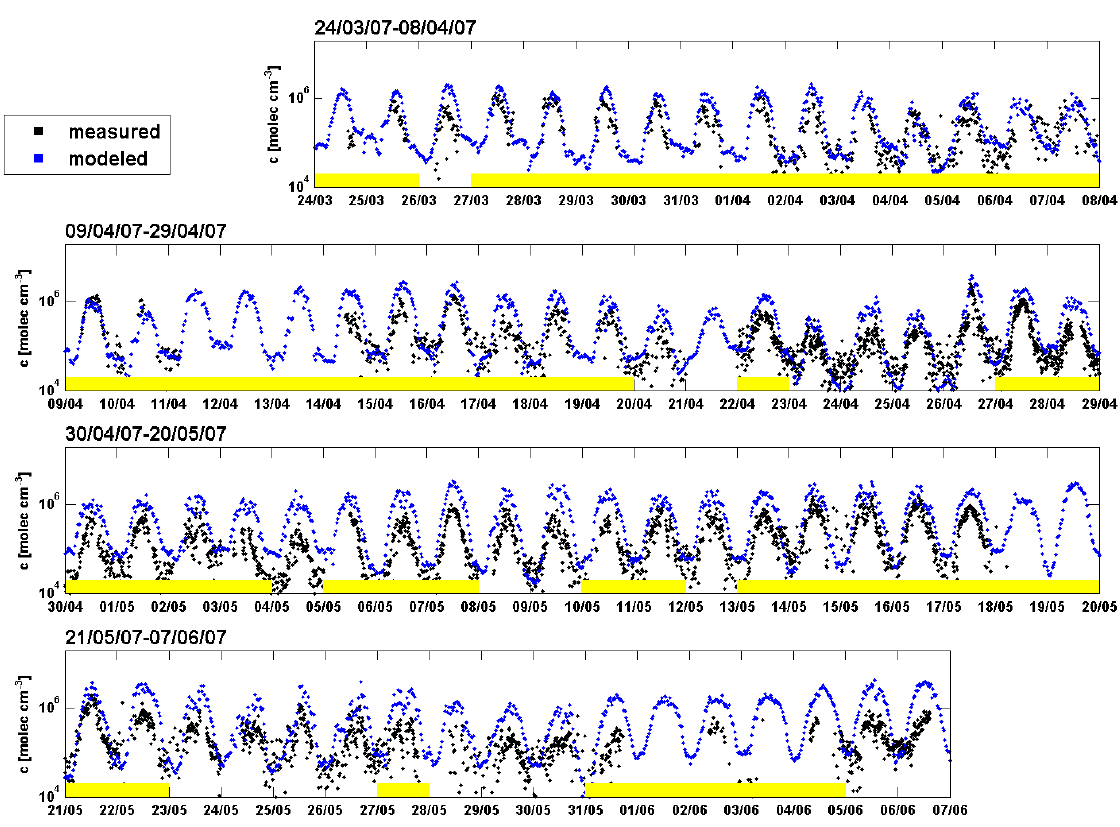
Fig. 7. Timeseries of 30-min averaged measured (black) and modeled (blue) concentrations of hydroxyl radical from March 24 to June 6, 2007 in Hyyti ¨ al ¨ a. Days with new particle formation are indicated with yellow bar at the bottom of the graph.